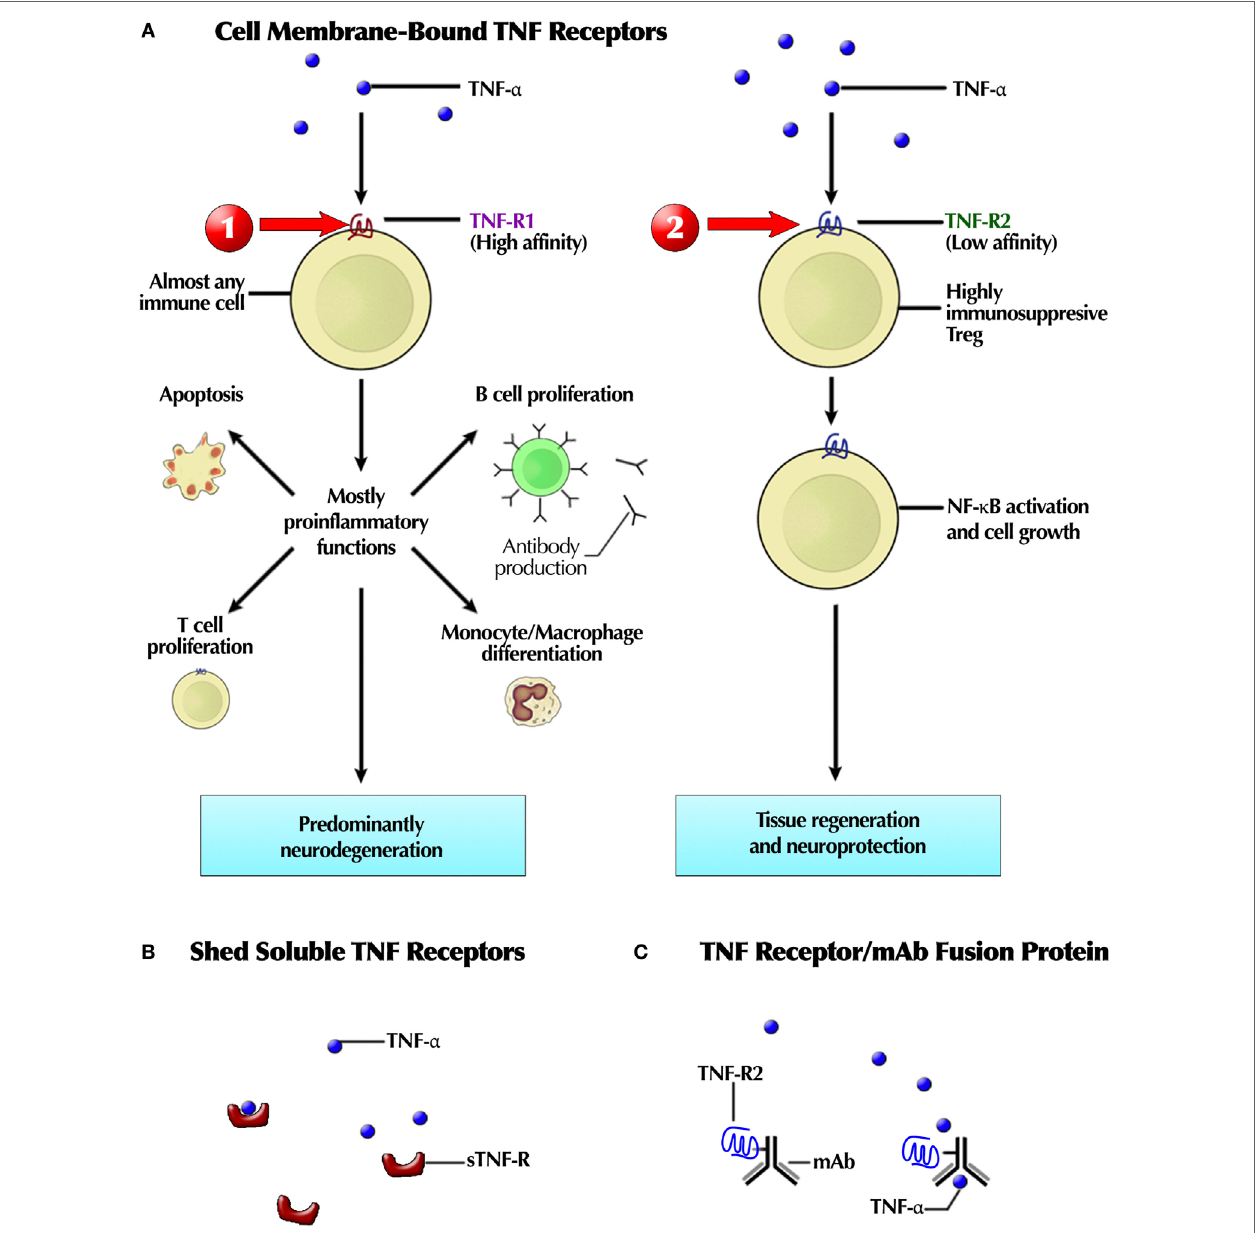
FiGURe 4 | (A) Schematic depiction of the targetable differences between TNFR1 and TNFR2 receptor pathways after binding of tumor necrosis factor (TNF), a natural agonist at both receptors. TNF- α , produced by activated macrophages, is a natural ligand at both receptors. TNFR1 receptor stimulation may trigger eventual neurodegeneration, so a selective TNFR1 antagonist may block it. TNFR2 receptor stimulation is associated this tissue regeneration and neuroprotection, hence a selective TNFR2 agonist could also treat neurogenerative diseases. In support of that premise, a selective TNFR2 receptor antagonist has destructive effects: inhibits regulatory T cell (Treg) proliferation, TNFR2 secretion from cells, and promotes T effector cell expansion. (B) Endogenous TNF soluble or decoy receptors, shed from membrane-bound TNFR, sequester TNF- α , preventing its inflammatory effects. (C) A receptor-Fc construct, combining a TNFR2 fragment with an mAb. This recombinant fusion protein is ethanercept. Red arrows indicate therapeutic intervention sites: (1) TNFR1 antagonist and (2) selective TNFR2 agonist. Not shown is the therapeutic potential of a TNFR2 antagonist for the treatment of cancer, inhibiting Treg proliferation, soluble TNFR2 secretion from normal cells, but increased effector T cell expansion, as demonstrated in vitro . Thus, the target shifts with the therapeutic purpose and